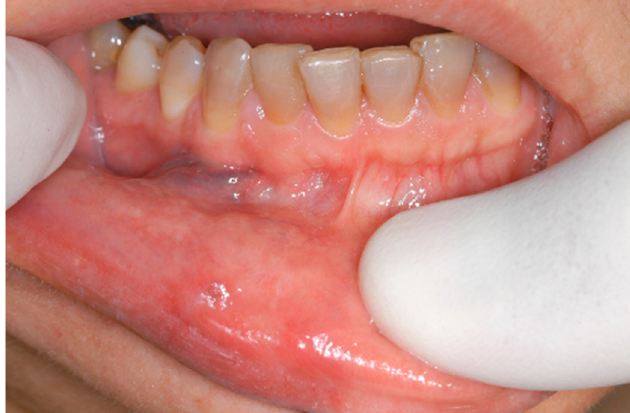
Figure 11. The aspect of healing at 2 weeks post operation. The excision was performed using an Er,Cr:YSSG laser.